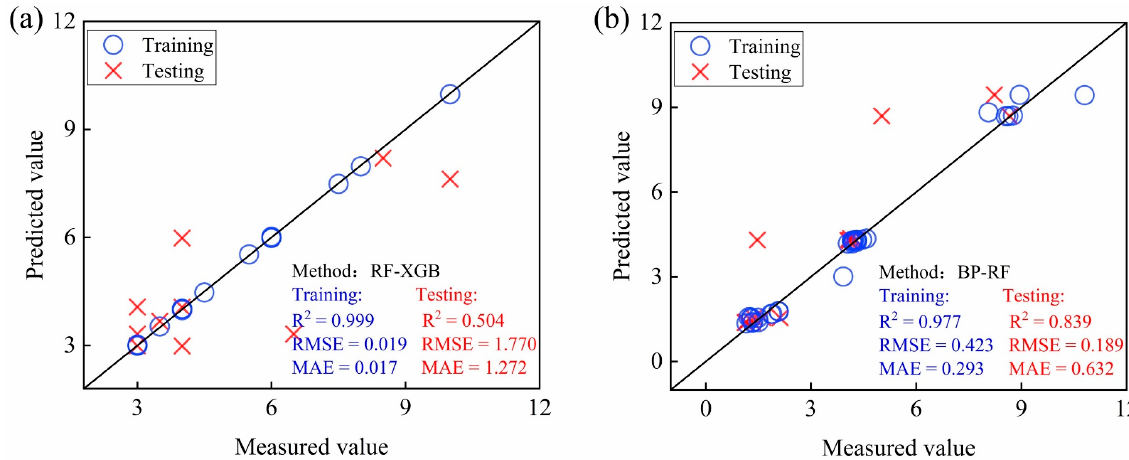
Figure 7. Scatter plots of measured water quality values and optimal model predicted values: ( a ) Chl-a, ( b ) TN, ( c ) TP, and ( d ) COD Mn . Figure 8. Comparison of measured and predicted values: ( a ) Chl-a, ( b ) TN, ( c ) TP, and ( d ) COD Mn .